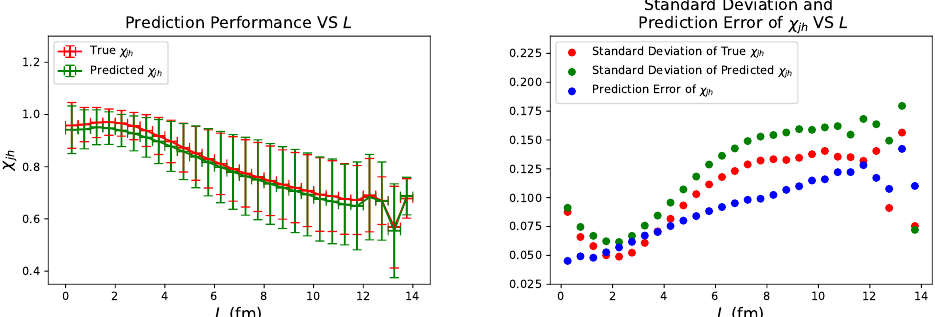
Figure 25 . Prediction Performance (left panel) and Standard Deviation, Prediction Error (right panel) VS L .